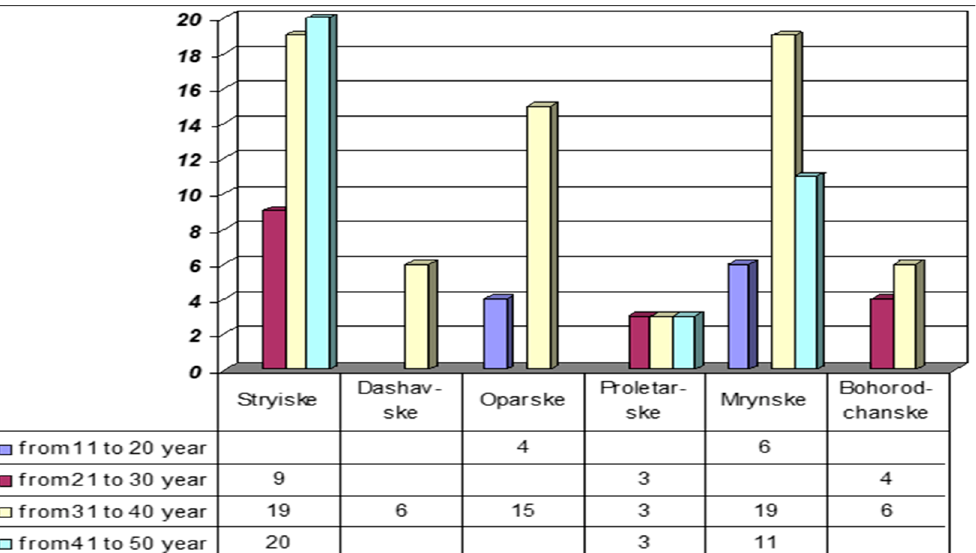
Figure 6. The structure of the fleet of gas-pumping units of the storage system according to the service life by the production departments of the UGS facilities. Source: [32].